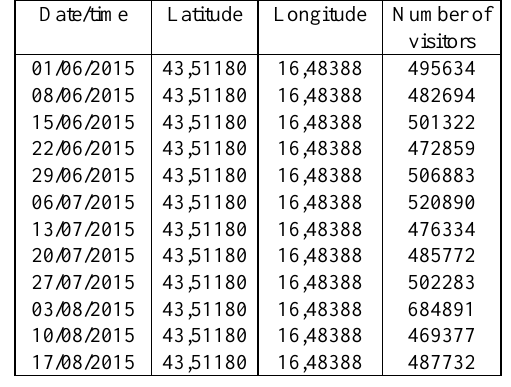
series data: aggregated number of visitors per